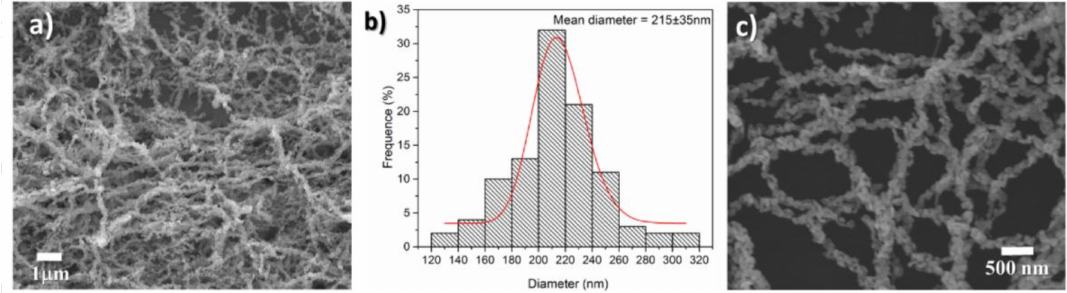
Figure 3. ( a ) Scanning electron microscopy picture of ZnO nanofibers; ( b ) a Histogram of diameter size distribution; ( c ) ZnO nanofibers at higher